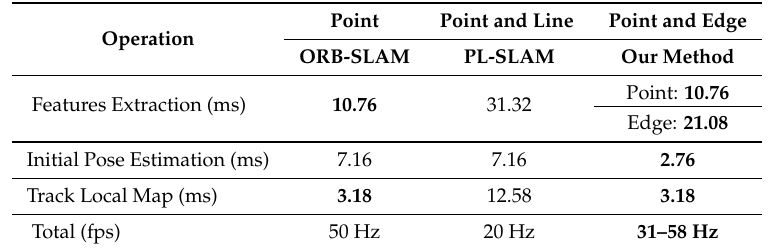
Table 2. Mean computing speed of camera tracking on the TUM RGB-D dataset (with an Intel Core i7-4790 CPU). Bold shows the best results.